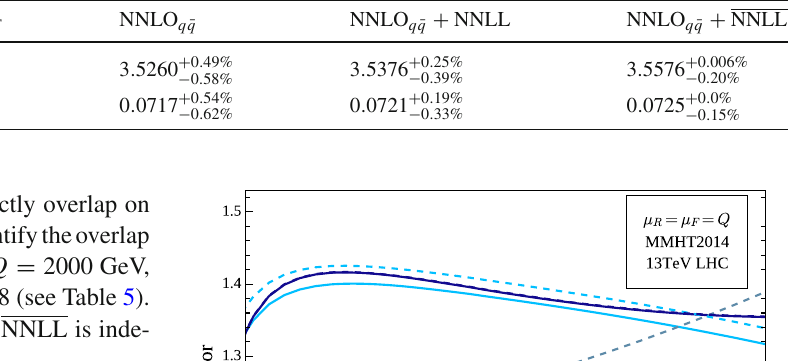
Table 10 Comparison of SV and SV + NSV resummed cross section in 10 − 5 pb/GeV for q ¯ q -channel at different central scales